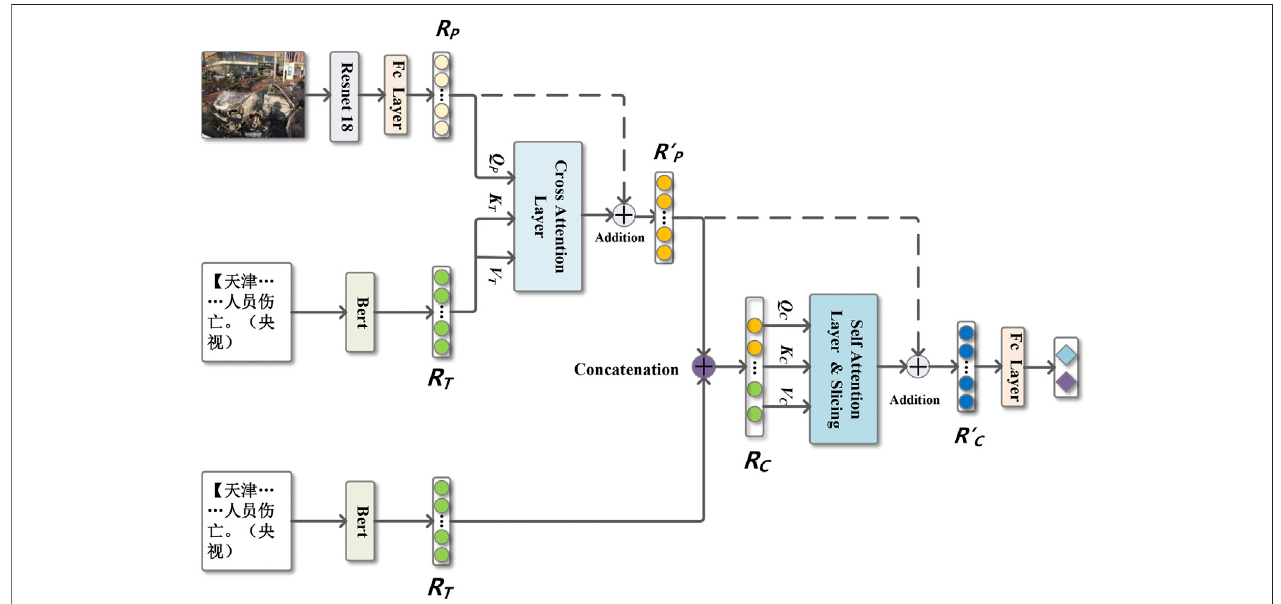
FIGURE 1 | Network structure of the MARN model. Instruction : Dotted lines represent residual